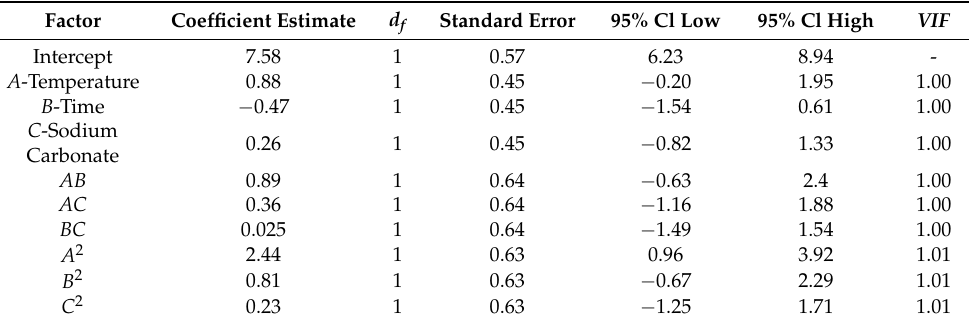
Table 6. Confidence analysis of the quadratic model.